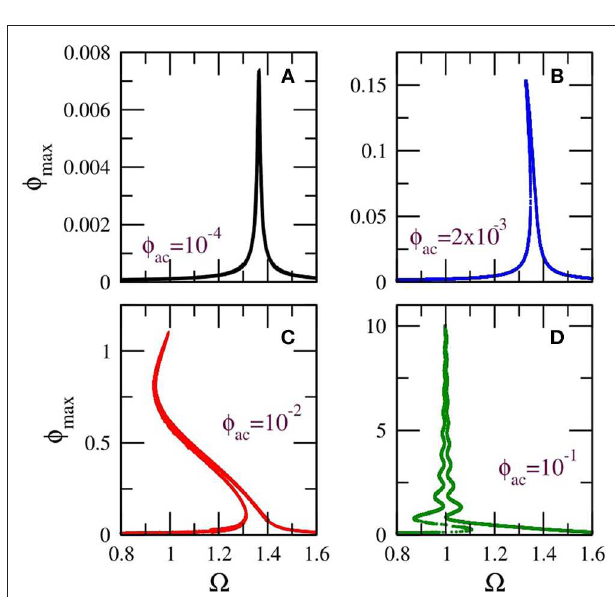
(cid:127) ) curves for a SQUID − 10 − 4 , (B) φ ac =